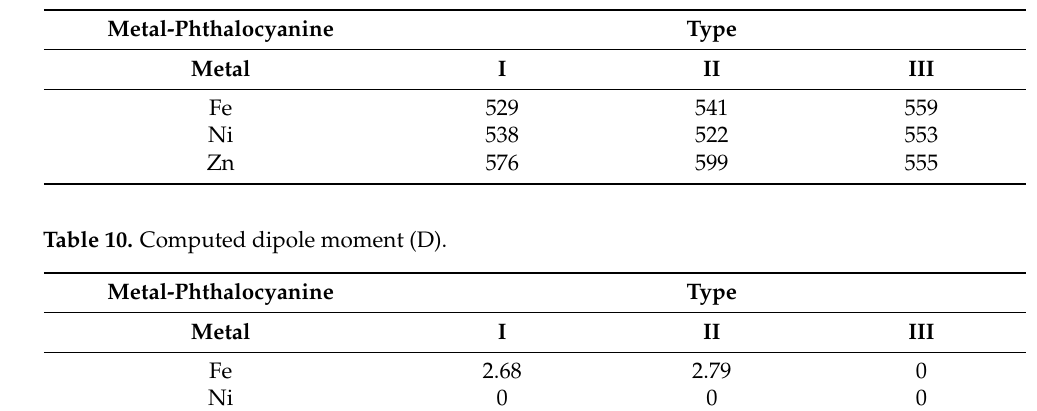
Table 9. Computed wavelengths Λ max (nm).